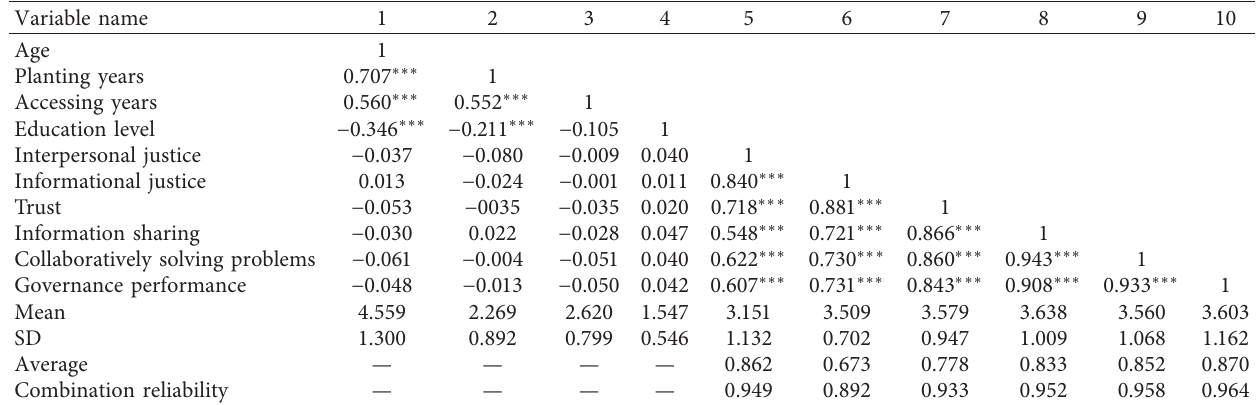
Table 2: Correlation analysis of